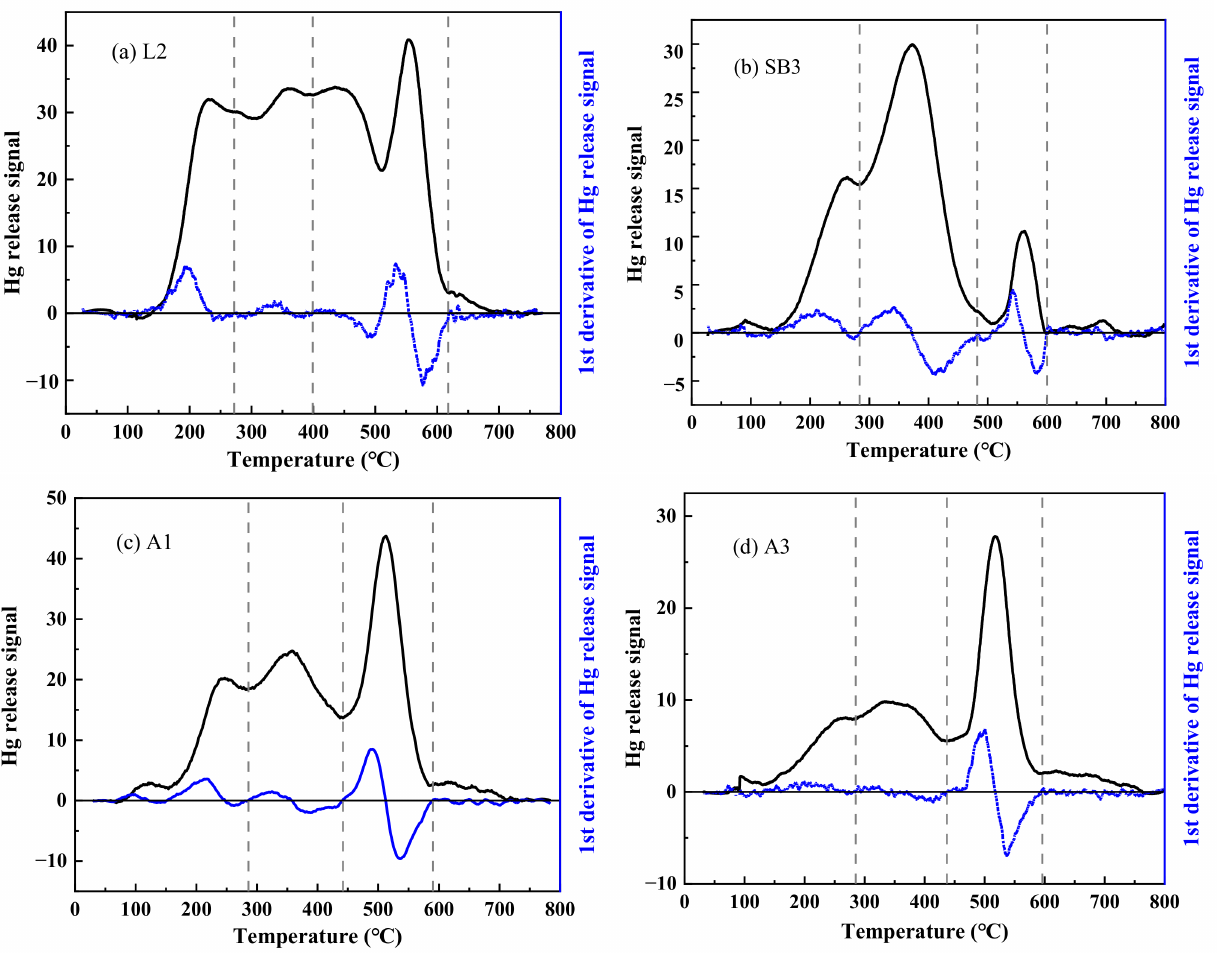
Figure 8. The thermogram of Hg release in coals: ( a ) L2, ( b ) SB3, ( c ) A1, ( d )